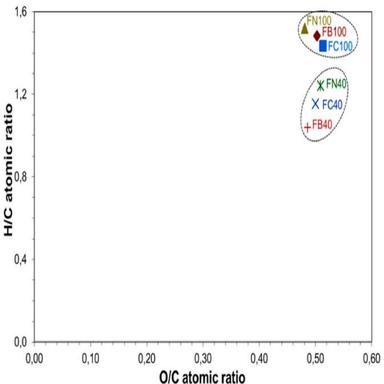
Composition by chemical methods for the biomass residues of 40 and 100 years old.